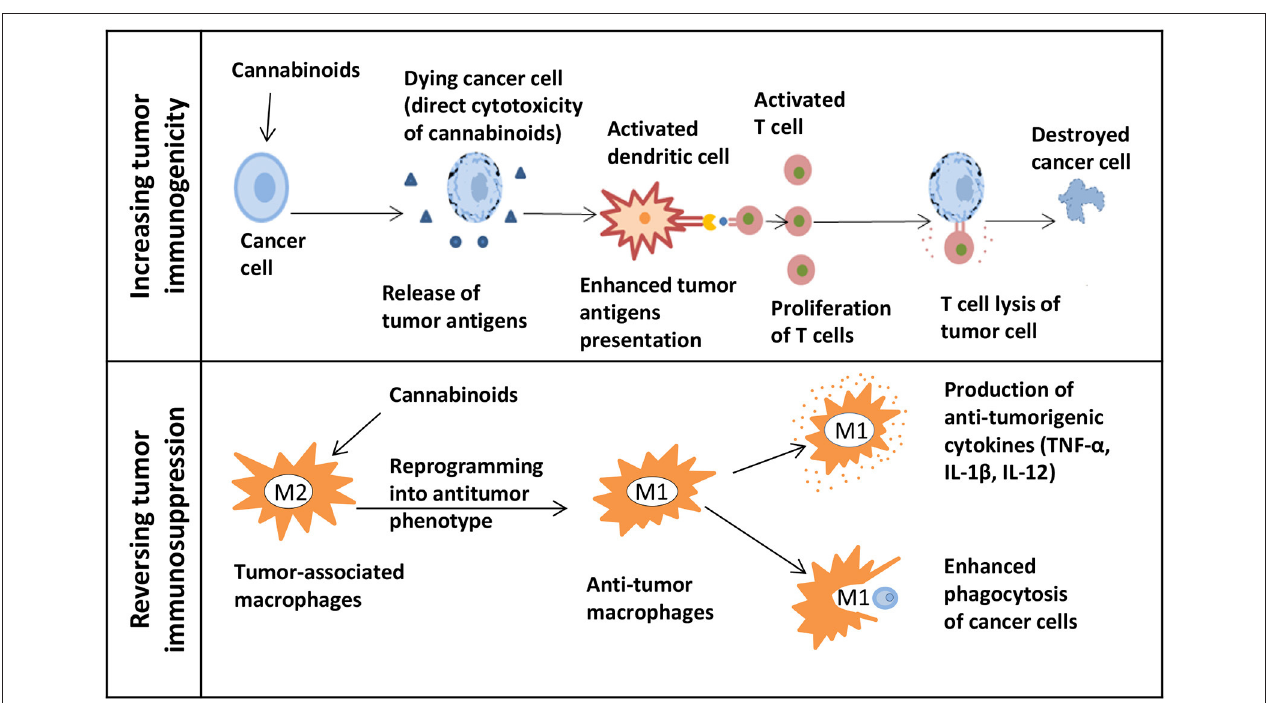
FIGURE 2 | The potential of cannabinoids for cancer immunotherapy. The upper panel shows how cannabinoids can increase tumor immunogenicity. The release of tumor antigens might be increased due to the direct cytotoxicity of cannabinoids in cancer cells. Next, the presentation of enhanced tumor antigens occurs followed by an increase in T cells-mediated immune response and T cells lysis of tumor cells. The lower panel shows how cannabinoids can reverse tumor immunosuppression. Macrophages can be reprogrammed into an antitumor phenotype with the help of cannabinoids. M1 immunostimulatory macrophages secrete the anti-tumorigenic cytokines and effectively phagocytize cancer cells.